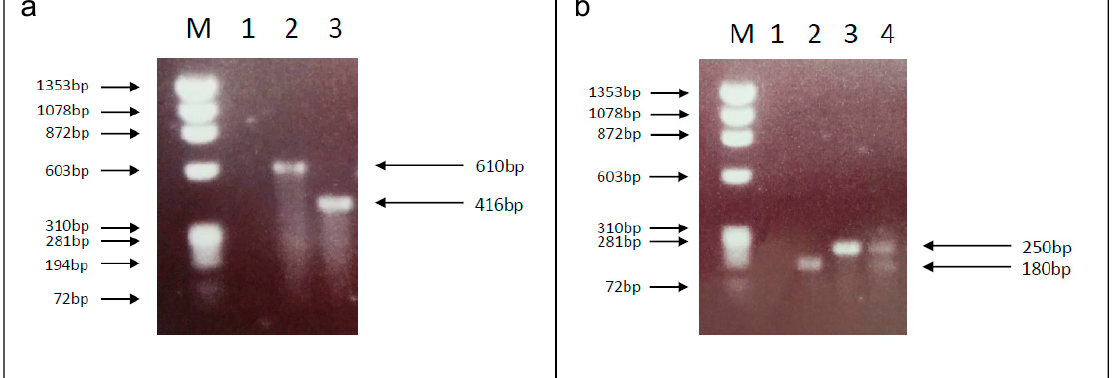
Figure 1. Gel images showing discrimination between ( a ) Culex torrentium / Culex pipiens [M = ϕ X174 marker, 1 = negative control, 2 = Cx. pipiens , 3 = Cx. torrentium ] and ( b ) Cx. pipiens form pipiens, Cx. pipiens form molestus and hybrid forms [M = ϕ X174 marker, 1 = negative control, 2 = form pipiens, 3 = form molestus, 4 = pipiens/molestus hybrid].